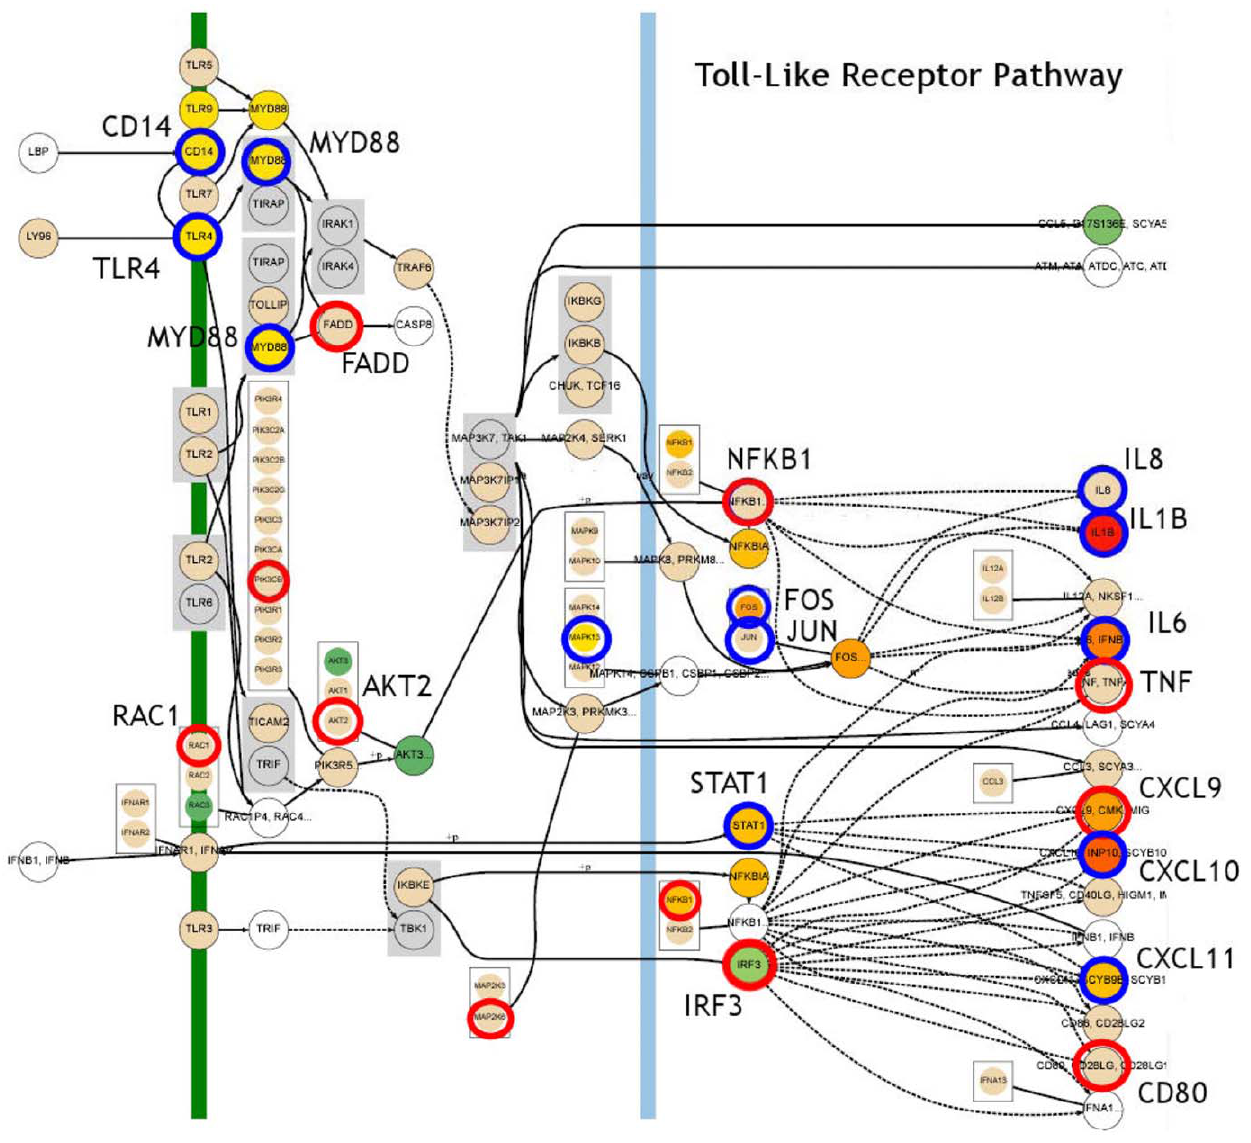
Figure 4. Wild type S.enterica serovar Typhimurium Toll-like Receptor Model with Mechanistic Genes. This is an example of the DBN model showing the mechanistic genes indicated by concentric rings around the node. The network model reveals the parent and child relationships and the state of gene expression for any selected time point. Increasing up regulation is indicated by the gradient colors from light yellow to dark red and down regulation is from light green to dark green. The red rings indicate mechanistic genes unique to the WT condition, while the blue rings indicate those in common with the MUT condition.